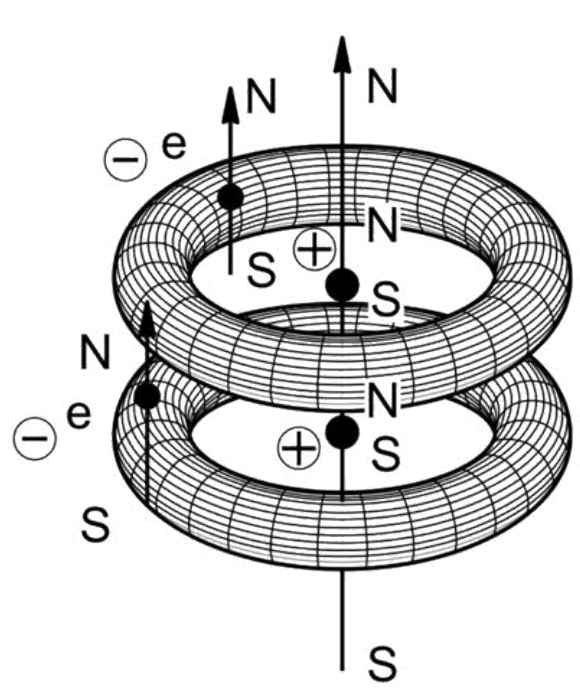
Figure 24: In this figure, we present a conceptual rendering of the new chemical species of Santilli magnecules [30] for the case of the elementary hydrogen magnecules ˜ H H × H (where × denotes magnecular bond). The species is obtained via the use of special electric arcs producing electric and magnetic fields over certain minimum values [ ? ], which arcs ionize the hydrogen molecule and polarize the electron orbits into toroids by therefore creating a new magnetic dipole moment which does not exist in the natural state. Polarized atoms bond together in the configuration of the figure which is stable at ambient temperatures by creating the new species of magnehydrogen (see Refs. [62] to [65]). It should be indicated that elementary magnecules between other selected atoms verify all hadronic laws for controlled nuclear fusions ([25], Section 4), for instance, of ˜ CO = 6 − C − 12 × 8 − O − 16 into 14 − Si − 28 without the emission of harmful radiations and without the release of radioactive waste [69]